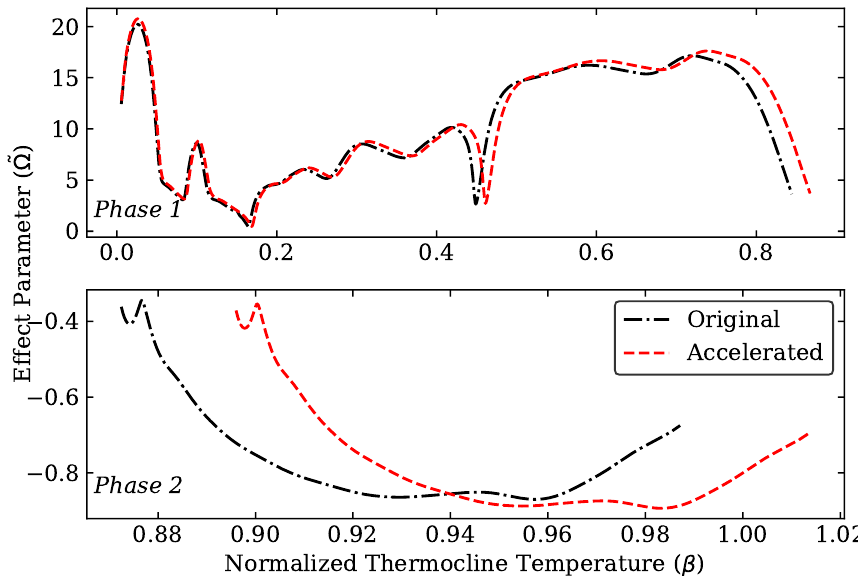
Figure 20. Scaled process curves of charging mode at the outlet location.